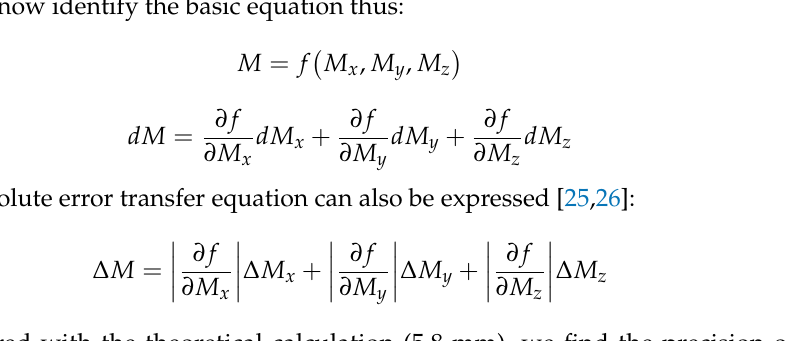
Figure 20. Flat digging precision: ( a ) Dry sand for test, ( b ) Wet soil for test. In the flat digging test of the grab dredger, the grab is placed in a vertical drop and inserted into the sand without an inclination. The precision of flat digging mainly depends on the compensation error and the error caused by the manual selection of measuring points. Comparing the test data of flat digging precision with the theoretical data, it is found that in the flat digging test, the digging precision is still within the controllable range. The transfer of the error depends on the nature of the error and the relationship between the theoretical and the measured results.